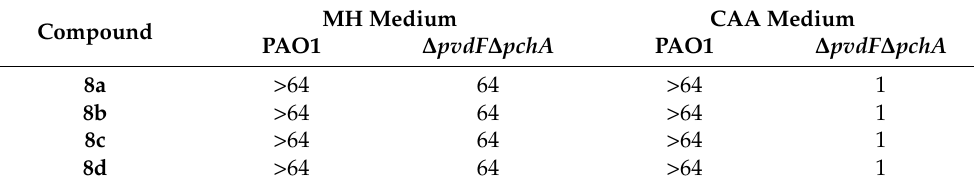
Table 1. MIC values determined for ciprofloxacin-siderophore conjugates 8a–d against P. aeruginosa PAO1 and ∆ pvdF ∆ pchA strains grown in MH or CAA (iron-restricted) medium (both strains were grown in the presence of increasing concentrations of 8a–d ; the MIC values were measured in µ M after 48 h in triplicates; ciprofloxacin was used as the positive control displaying an MIC value of 48 ± 1.2 µ M). MH Medium CAA Medium Compound PAO1 ∆ pvdF ∆ pchA PAO1 ∆ pvdF ∆